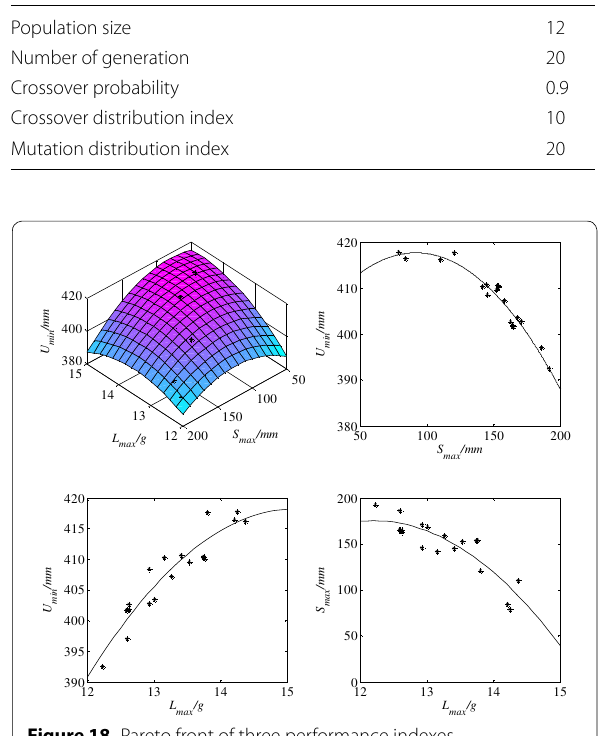
Figure 18 Pareto front of three performance